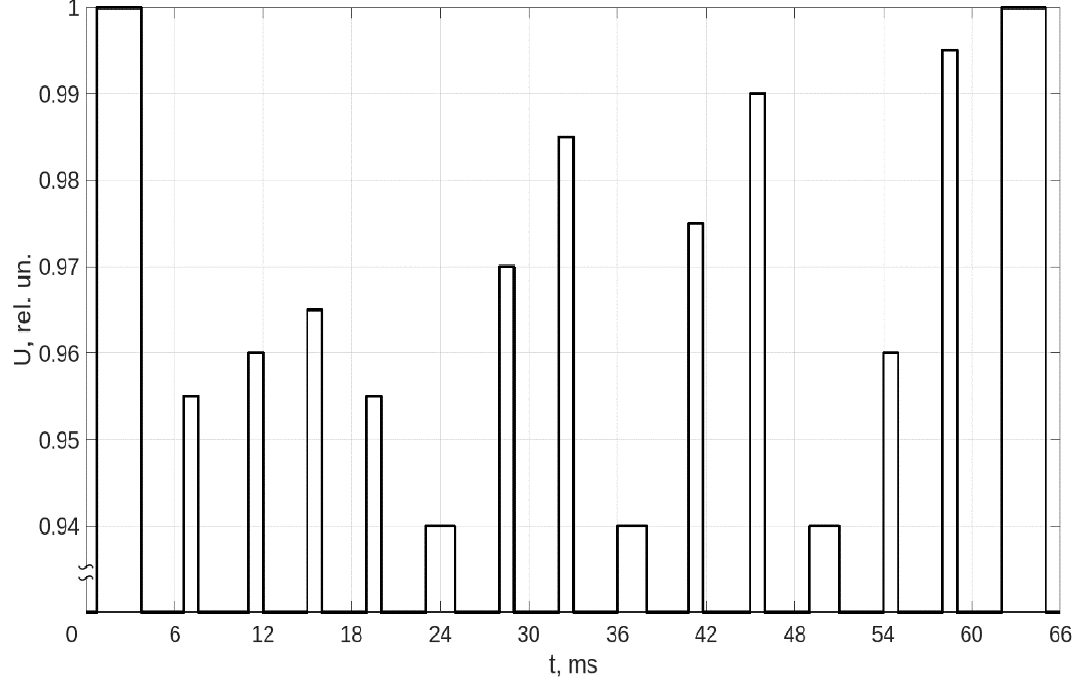
Figure 1. A sequence of command codes in the form of rectangular pulses for transmitting a control command in analog form via FOCL.